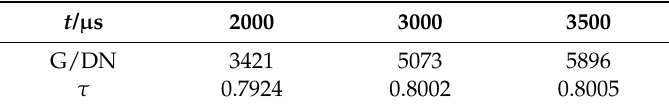
Table 1. The results of transmittance at different integration times.